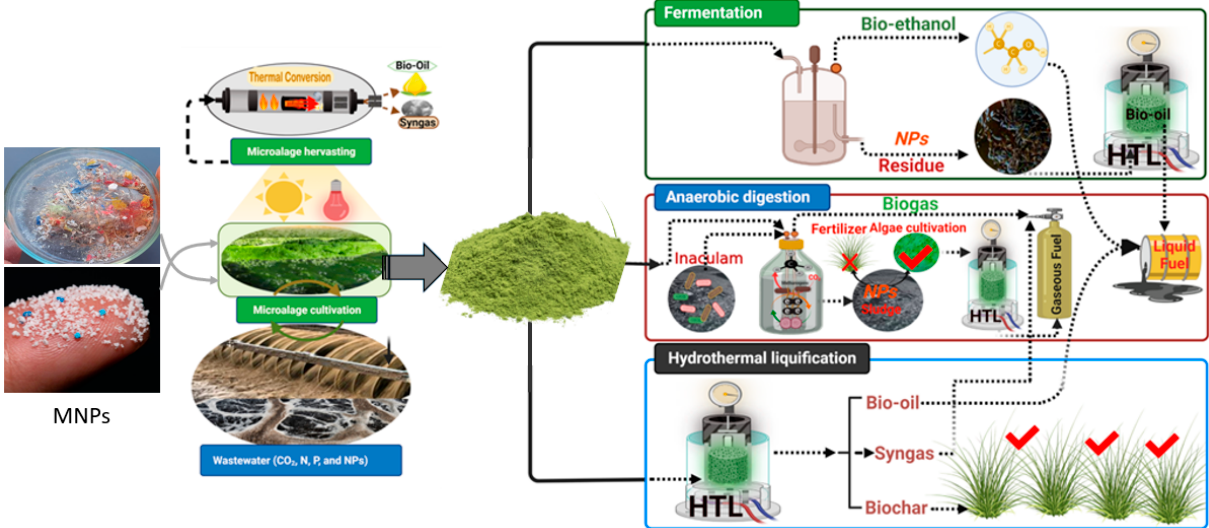
Figure 4. The suggested microalgae–MNP integrated routes for biofuel production using wastewater for cultivation. HTL: hydrothermal liquefaction; MNPs: micro-/nanoplastics.